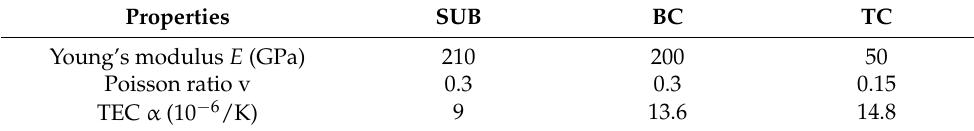
Table 1. Mechanical and thermal properties for all layers material [56–59]. Properties